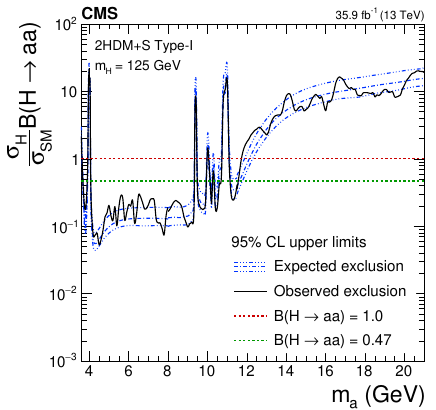
Figure 8 . Observed (black) and expected (blue, median and 68%) model-speci(cid:12)c 95% CL upper B (H ! aa) =(cid:27) limits on (cid:27) as a function of m for the Type-I 2HDM+S at tan (cid:12) = 1 : 5 and H SM a m = 125 GeV. The assumed model branching fractions for pseudoscalar Higgs boson decay to (cid:22)(cid:22) H and (cid:28) (cid:28) are taken from ref. [71] and are approximately independent of tan (cid:12) . depends only on m and m [7, 71]. Thus, these results can be converted into upper limits (cid:22) (cid:28) B (H ! aa) =(cid:27) on (cid:27) . Contours for di(cid:11)erent B (H ! aa) values are overlaid. H SM